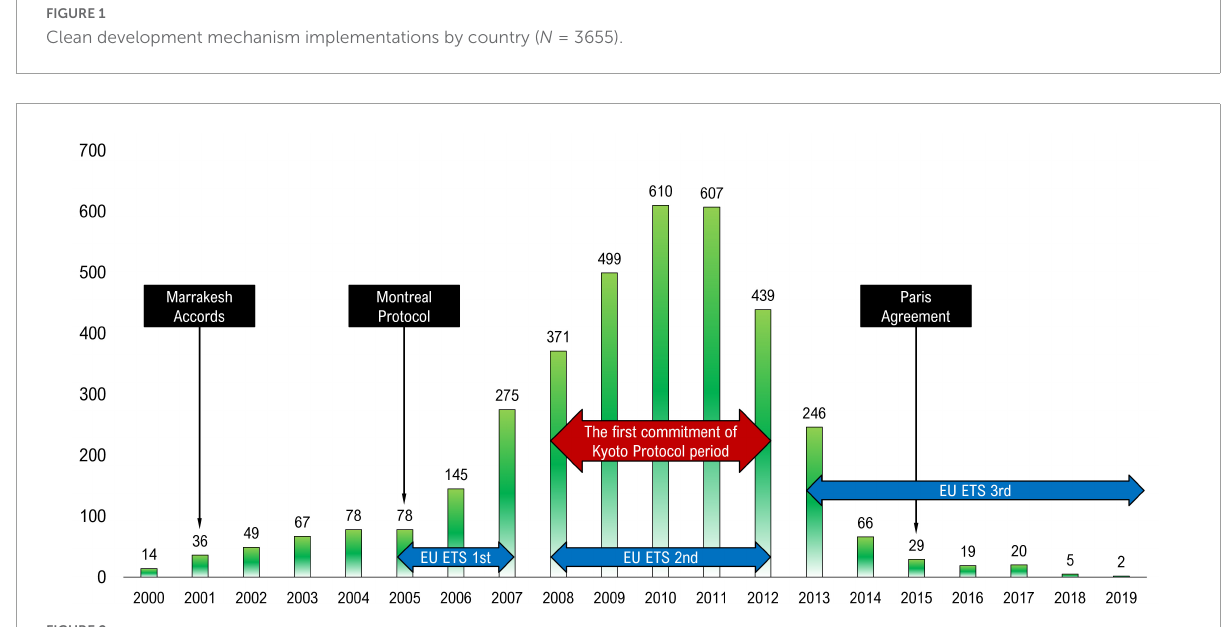
FIGURE2 Institutional schemes over climate change and CDM implementations by year ( N =